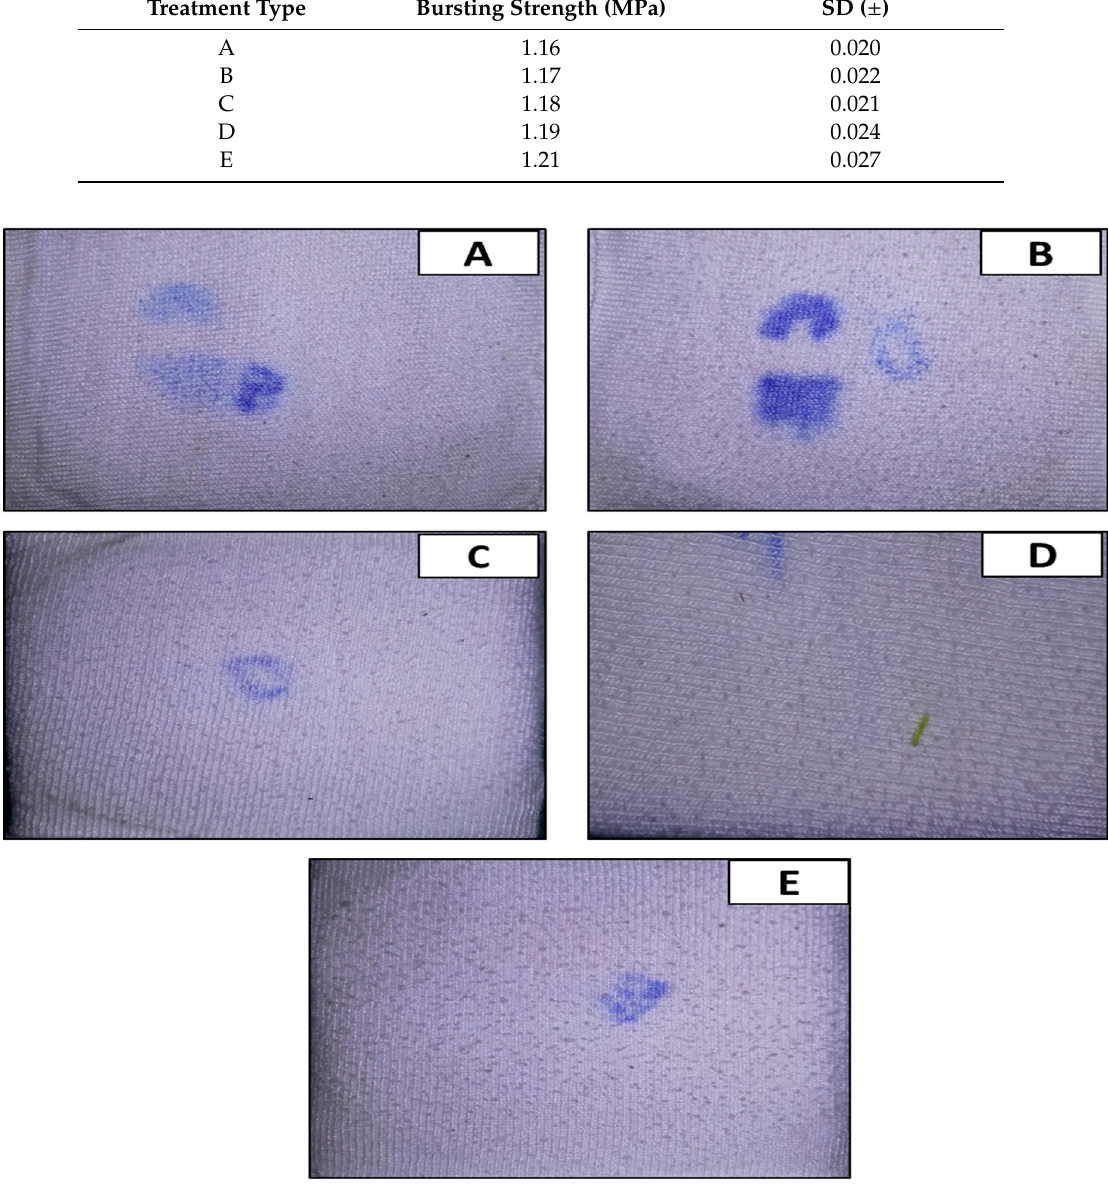
Figure 3. Picture of samples after finishing treatments ( A ) grey fabric, ( B ) simple wash, ( C ) normal finish, ( D ) silicon finish, and ( E ) wicking finish).